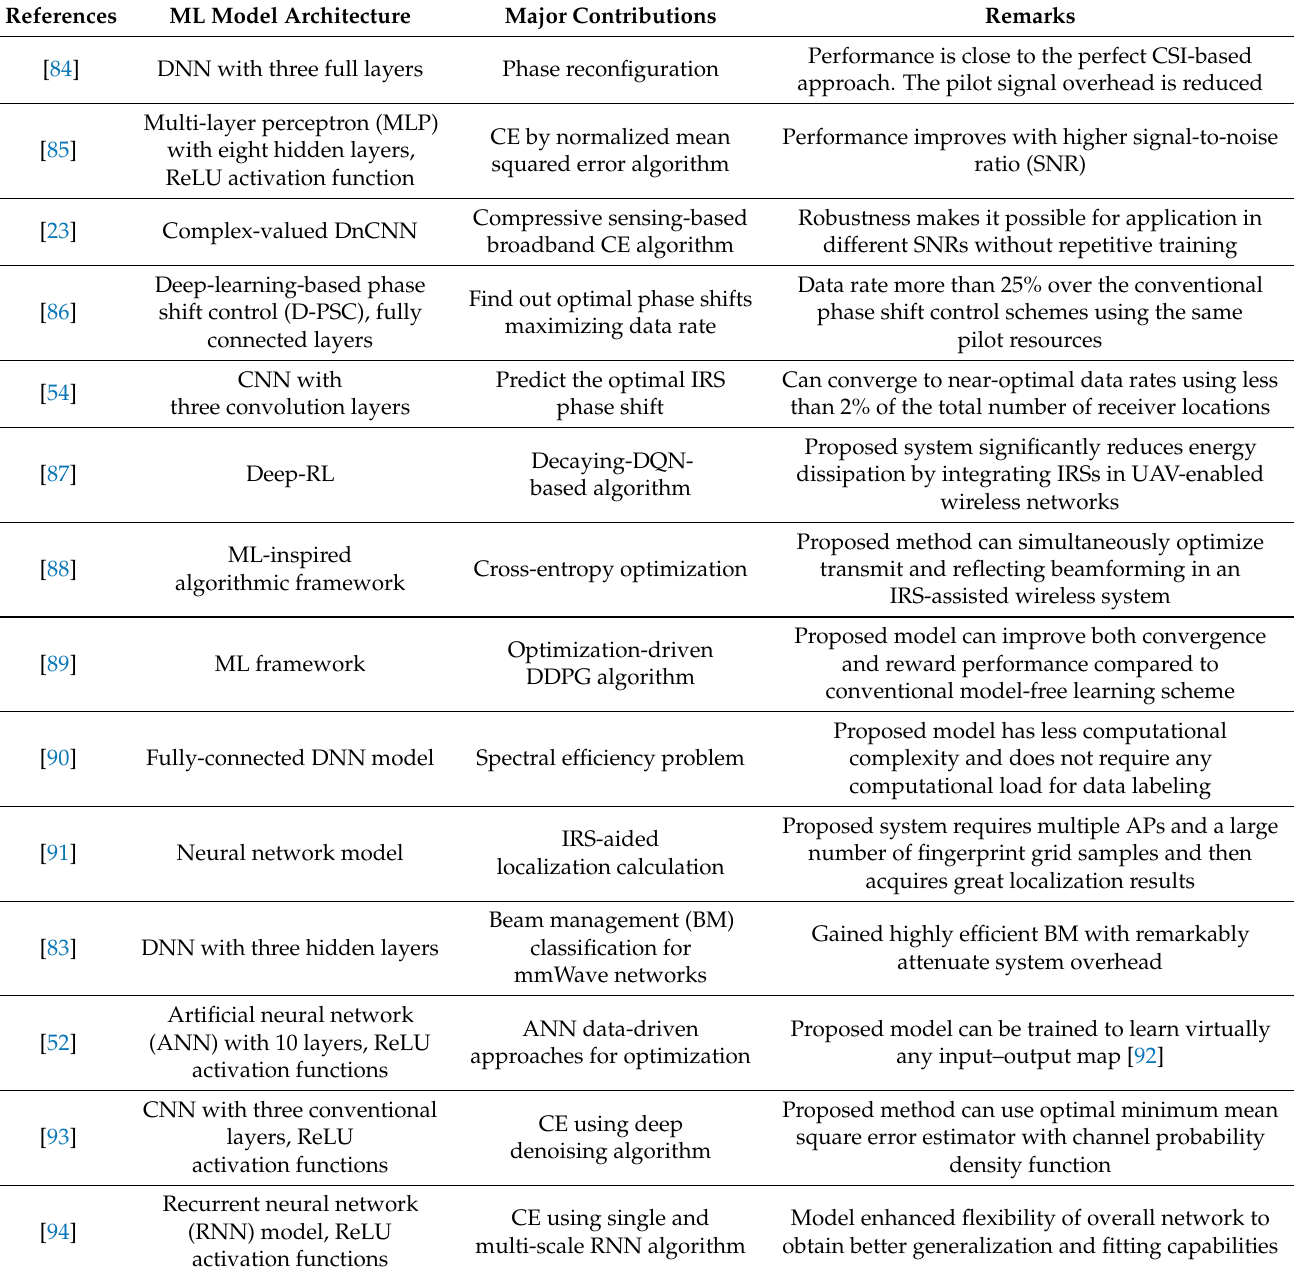
Table 1. Comparison between ML-based technologies for IRS-assisted wireless communication.